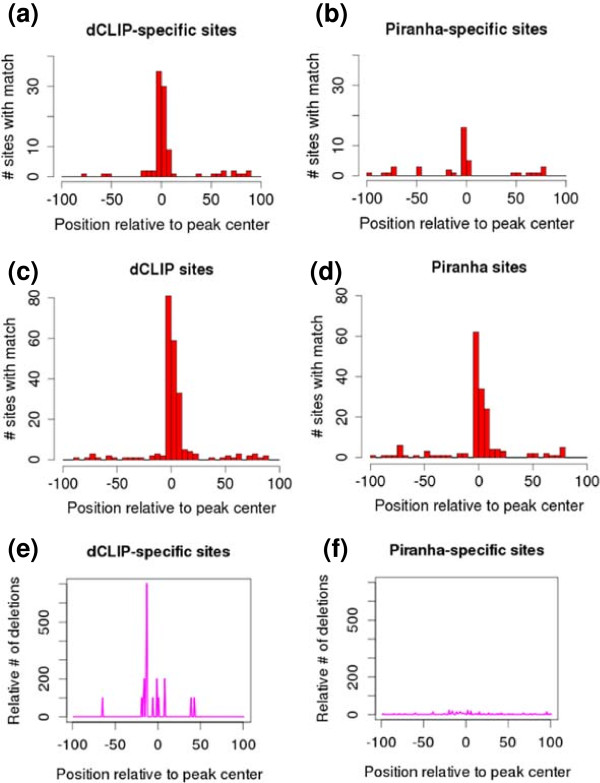
Comparison of the dCLIP software and the Piranha software. (a,b) Motif match counts within target sites found by only one method and not the other. Targets sites were extended to 100 bp both upstream and downstream from the peak center. Then the RNA sequences covered by the target sites were scanned for matches to any 7-mer from the reverse-complement of the mature miR-124 sequence (GGCAUUCACCGCGUGCCUUA). The x-axis is the relative distance of motifs to the peak centers and the y-axis is the number of sites with motif matches. (c,d) Total motif match counts within target sites found by each method. (e,f) Targets sites were extended to 100 bp both upstream and downstream from the peak center. Then the deletion mutations were counted within the method-specific target sites in both miR-124 transfected and the control conditions. The mutation count number in the transfected condition was divided by the mean count number in the control condition to produce a relative ratio. The relative counts were then plotted for each set of method-specific sites. The x-axis is the relative distance of deletions to the peak centers and the y-axis is the relative counts.